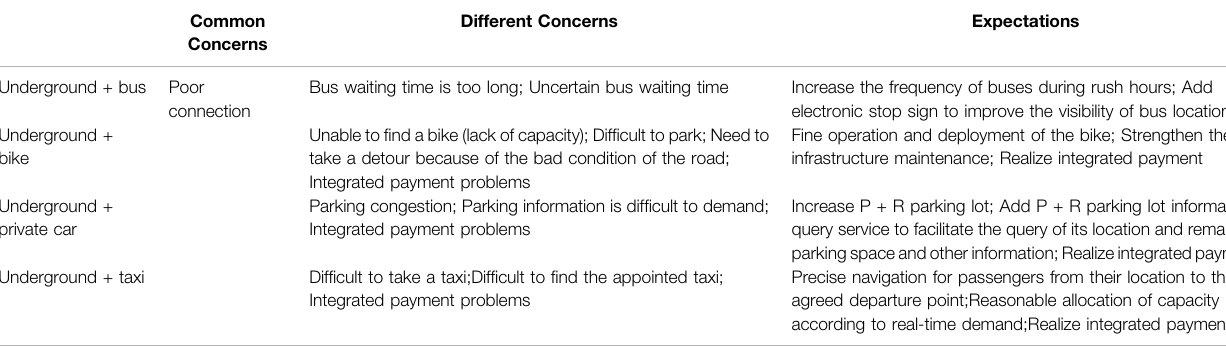
TABLE 2 | Concerns and expectations for four